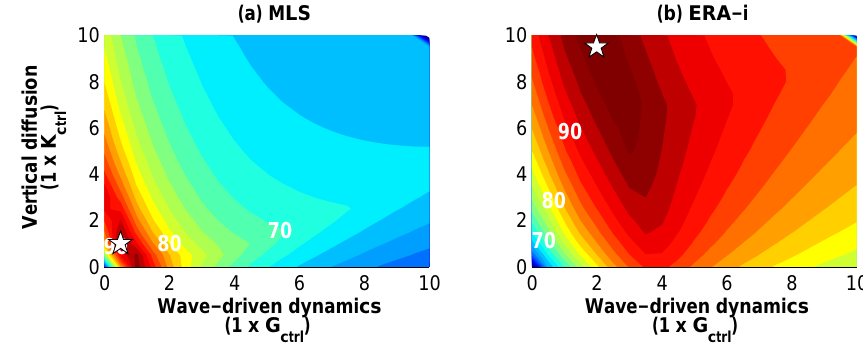
Figure 10. The total scores (%) of the synthetic MLS and ERA-i tape recorders at 400K.